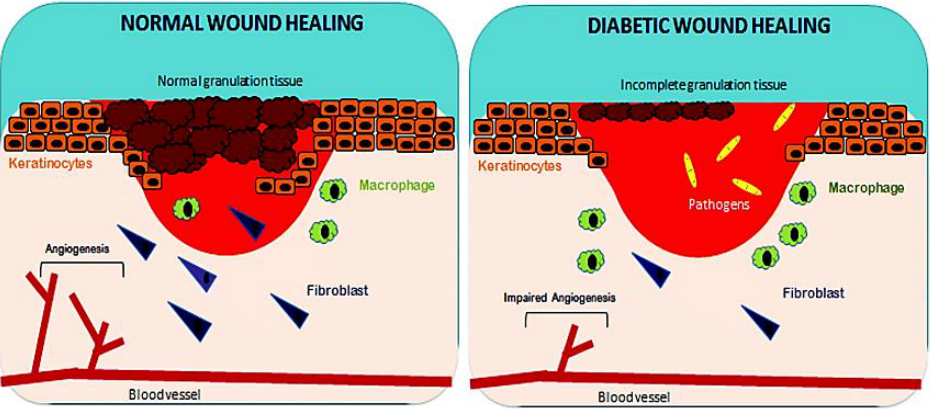
Figure 3. Factors affecting normal and diabetic wound healing. Reproduced from [1], with permission from Royal Society of Chemistry, 2017.